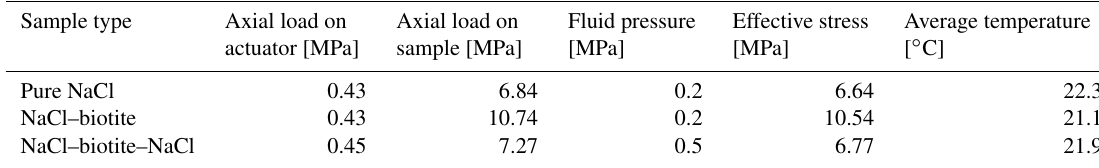
Table A1. Experimental conditions for oedometric compaction experiments.